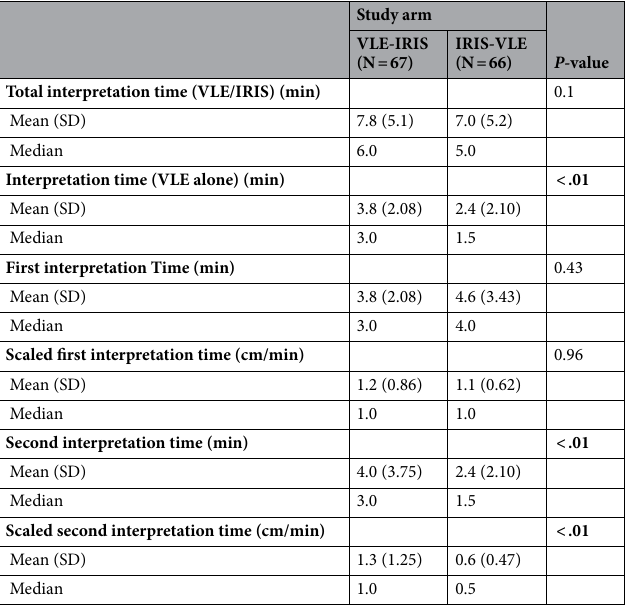
Table 2. VLE interpretation times between study groups. All time values are displayed as minutes, except as otherwise noted. All P-values are based on the Kruskal–Wallis test. Scaled interpretation time denotes time of interpretation as a function of BE length in cm. Significant values are in bold. SD standard deviation, VLE volumetric laser endomicroscopy, IRIS intelligent real-time image